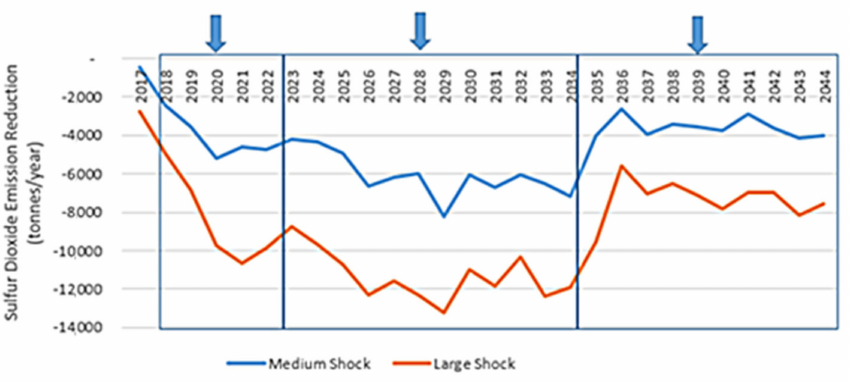
Figure 3. Reduction in SO 2 emissions from NSW coal-fired power generation projected due to demand shocks showing years selected for regional air quality